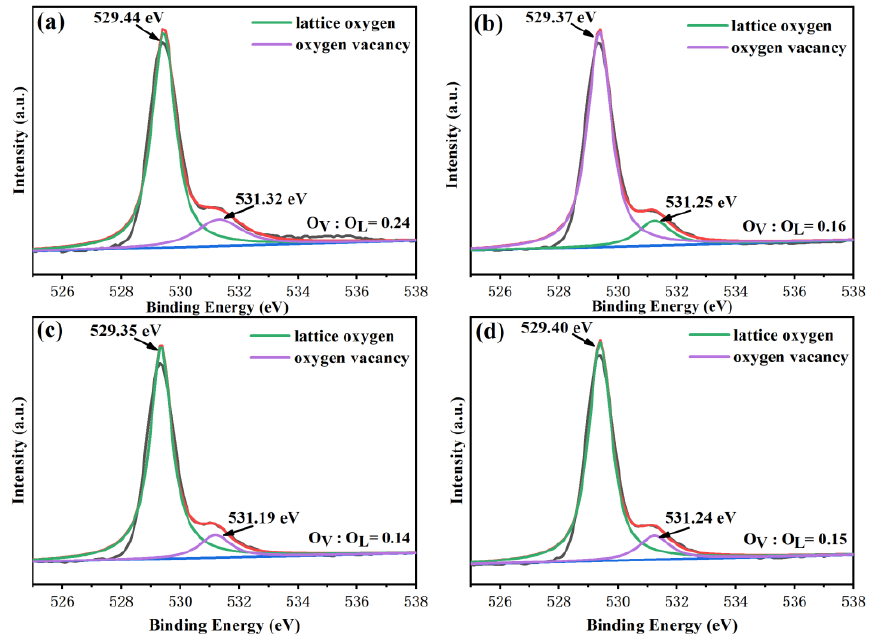
Figure 6. O1s orbital XPS fitting diagram of the BSFM films with different Sm content: ( a ) x = 0 mol%; ( b ) x = 2 mol%; ( c ) x = 4 mol%; ( d ) x = 6 mol%. The black lines refer to the original curve, the red lines refer to the fitting curve, and the blue lines refer to the background line.